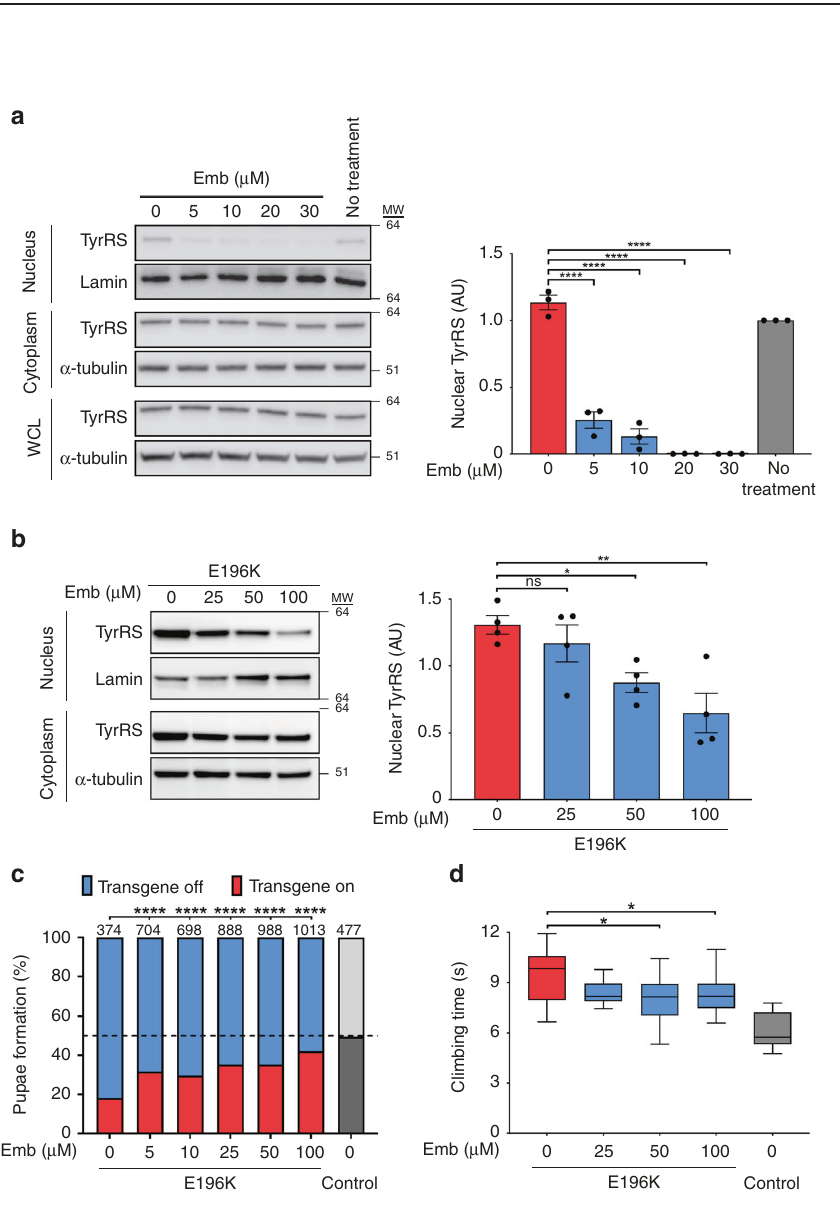
Fig. 4 Pharmaceutical exclusion of TyrRS from the nucleus partially rescues the toxicity of TyrRS mutants. a, b Subcellular localization of TyrRS after treatment with different concentrations of embelin (Emb) in HEK293T cells (14 mM DMSO) ( a ) and in fl ies pan-neuronally ( nSyb-Gal4 ) expressing TyrRS (42 mM DMSO) ( b ). Emb was dissolved in DMSO, which has no effect on TyrRS nuclear localization. α -Tubulin and Lamin served as cytoplasmic and nuclear markers, respectively. n ≥ 3 independent biological replicates, one-way ANOVA with Dunnett Multiple Comparisons test. Bar charts presented as means ± s.e.m. c Pupae formation of Drosophila ubiquitously ( Act5C-Gal4 ) expressing TyrRS-E196K after administration of different concentrations of embelin. Emb was dissolved in 0.3% DMSO (42 mM). Percentages indicate ratio of pupae expressing the TyrRS transgene or not. Dashed line, expected 50:50 pupation rate in the control condition (no transgene). Number of counted pupae (n) are indicated above the chart χ 2 -test. d Climbing performance of fl ies pan-neuronally ( nSyb-Gal4 ) expressing TyrRS-E196K raised on food containing Emb, dissolved in 0.3% DMSO (42 mM). n ≥ 10 independent groups of fl ies. One-way ANOVA with Dunnett Multiple Comparisons test. Box plots show the median, 25 – 75% percentiles, and 1.5 interquartile range. Source data are provided as a Source Data fi